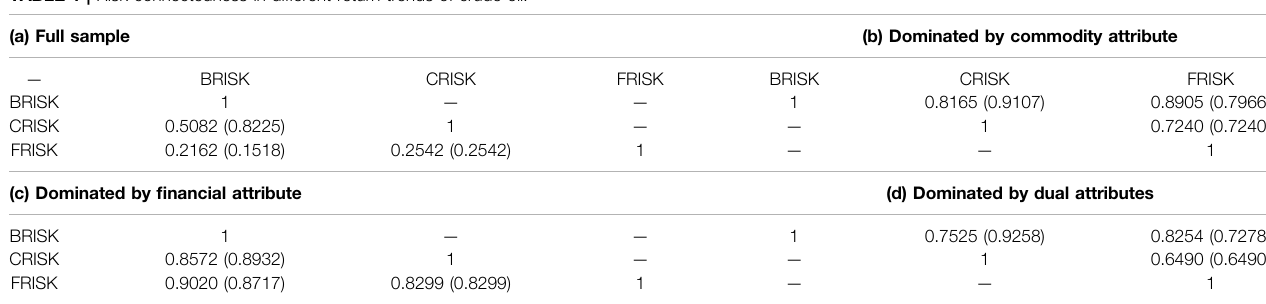
TABLE 1 | Risk connectedness in different return trends of crude